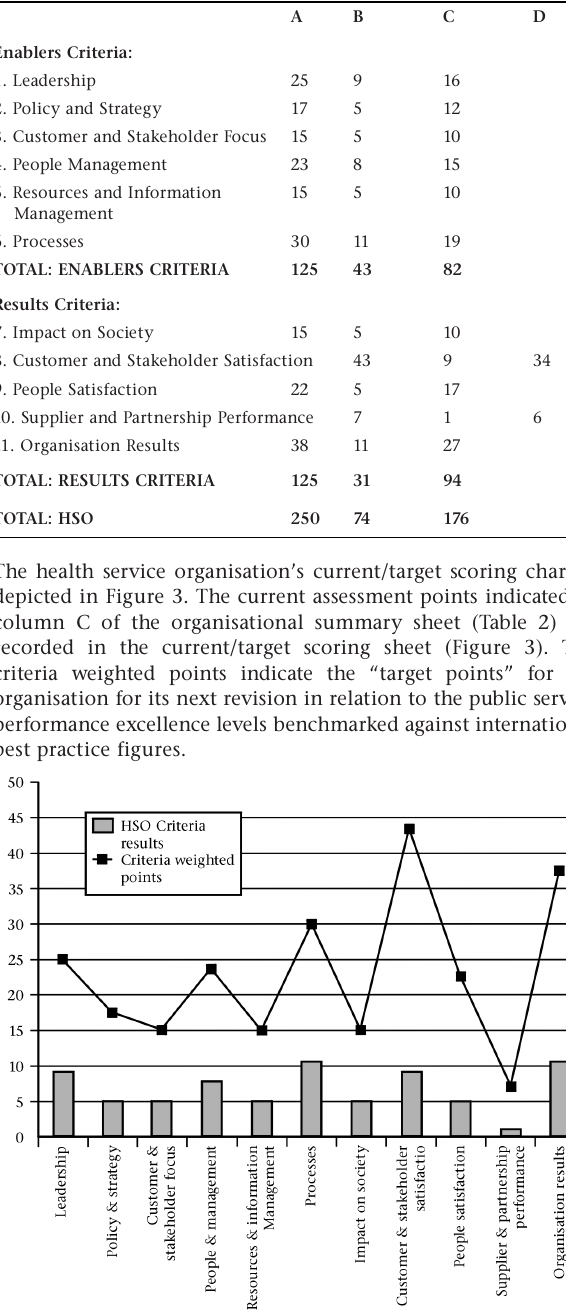
Figure 3: HSO current/target scoring